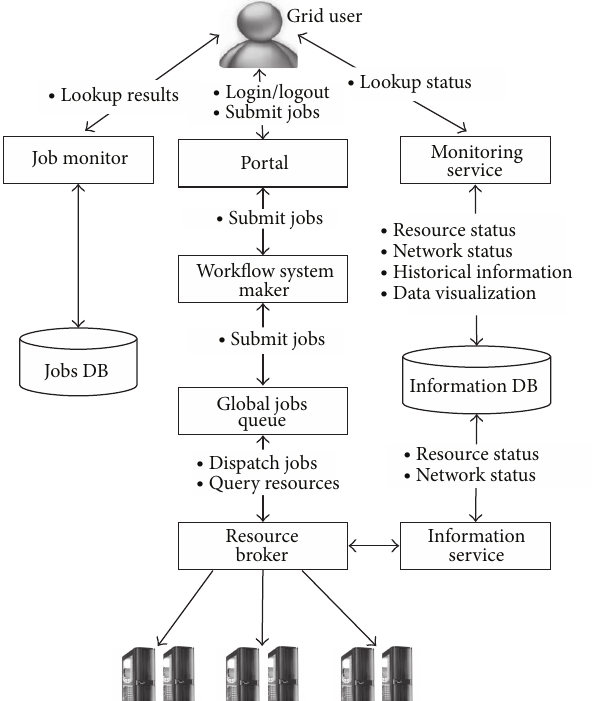
Figure 2: DIANA scheduler (taken from